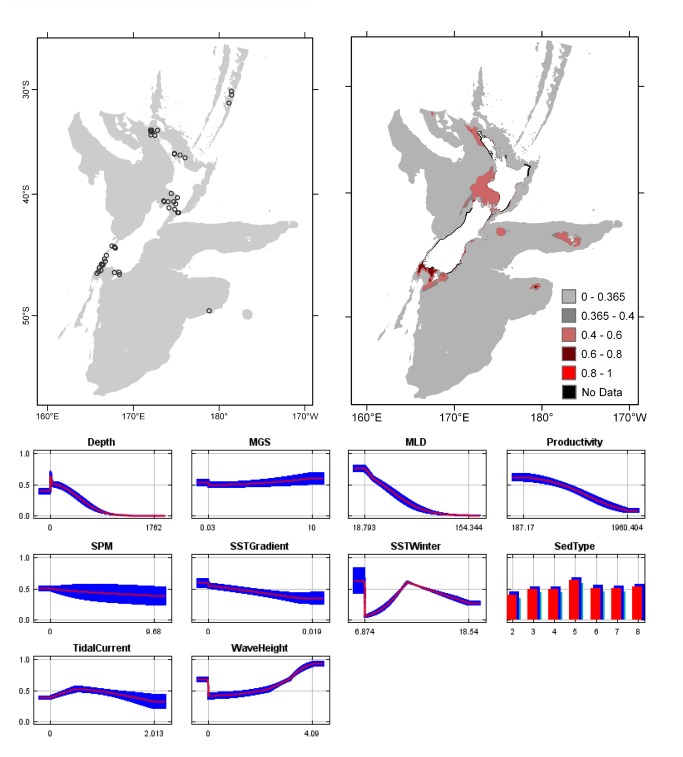

Cellaria

tenuirostris
 known distribution (left), predicted suitable habitat (right), and fitted responses curves (marginal).For the predicted distribution, logistic probabilities less than the 10th percentile presence value indicated cells were unsuitable habitat. Probabilities of 0.4–0.6 indicated habitat suitability typical of the presence records, values of 0.6–0.8 and 0.8–1 indicated favourable and highly suitable habitat, respectively. Black cells had missing data in one or more environmental layer. Independent records are layed over the predictions. Marginal response curves show how the prediction changes for different values of each variable when all other variables were at their average sample value. Individual response curves are shown in Figure S3. For the categorical variable Sediment type: 1 = deep ocean clays; 2 = calcareous gravel; 3 = volcanic; 4 = calcareous mud; 5 = gravel; 6 = mud; 7 = sand; 8 = calcareous sand.